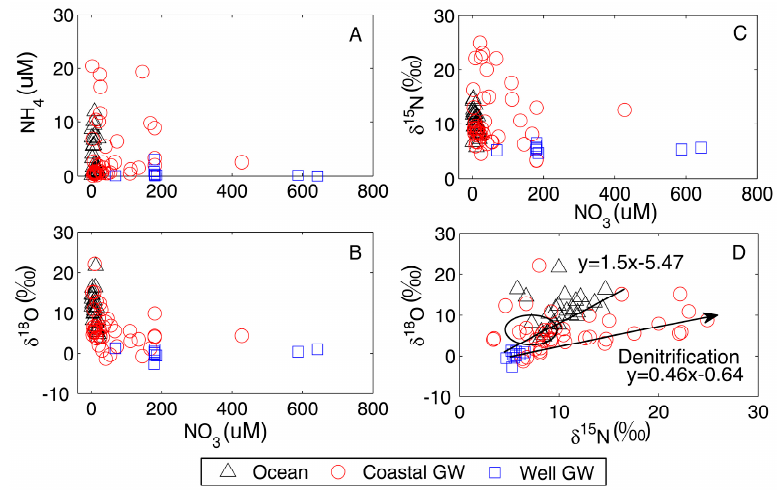
Figure 4. Nitrate concentrations plotted against ammonium ( A ), δ 18 O NO3 ( B ), and δ 15 N NO3 ( C ) and δ 15 N NO3 plotted against δ 18 O NO3 ( D ). In D the circle represents the range of data found in Monterey Bay ocean water by [35]. The arrow displays what a 2 δ 15 N NO3 :1 δ 18 O NO3 denitrification trend would look like. The line is a regression of well groundwater and ocean water.